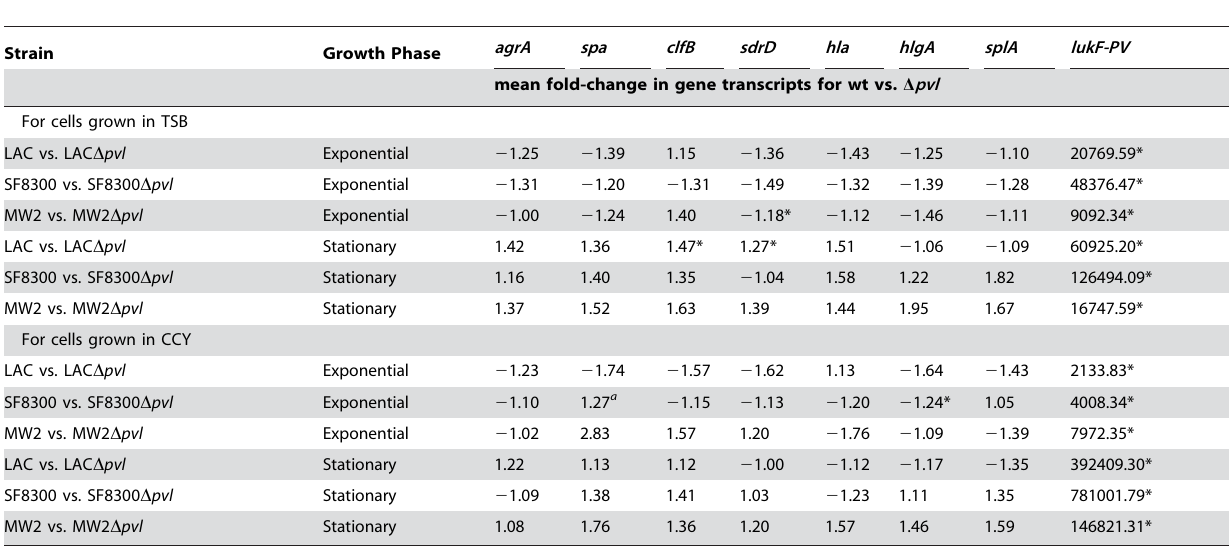
6 TaqMan real-time RT-PCR was performed as described in Methods. Results are expressed as the mean fold-change of 3–5 experiments (exponential growth, Exp.) or 4– 7 experiments (stationary phase of growth, Stat.) with one exception a (one of the TaqMan reactions failed, n=2). The relative expression level of each transcript (dCT) was compared in parent vs. D pvl strains using a paired Student’s t -test ( * P , 0.05 versus D pvl ). Except for lukF-PV , none of the transcripts in any of the strains met standard criteria required for differentially expressed genes ( . 2-fold change in the wild-type vs. D pvl mutant strain and P ,